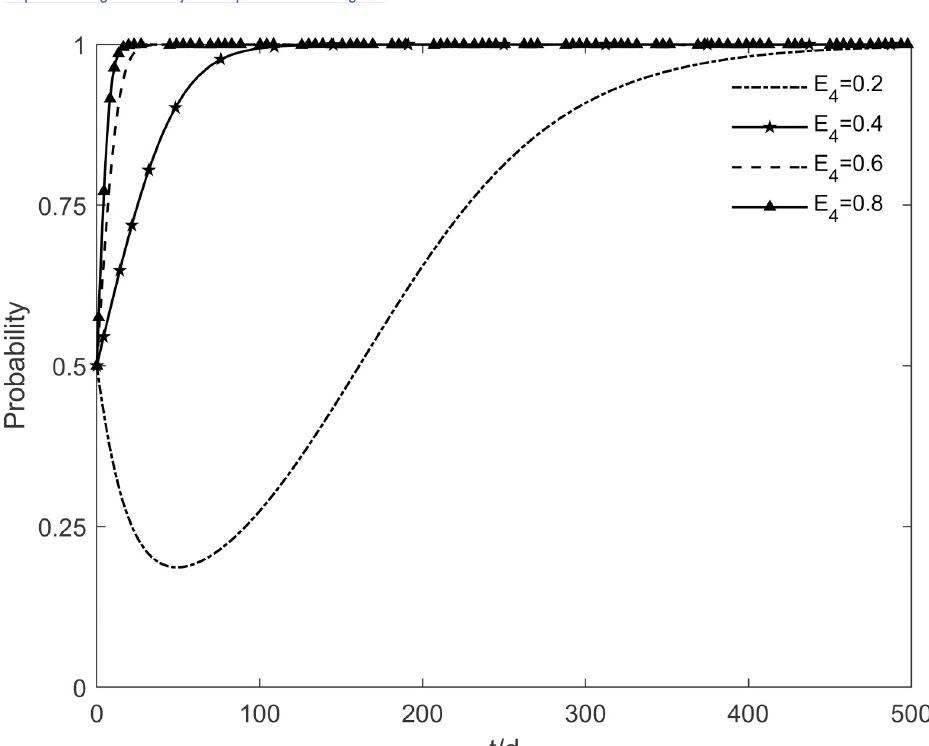
Fig 23. The impact of E 4 on residents’ strategic choices.